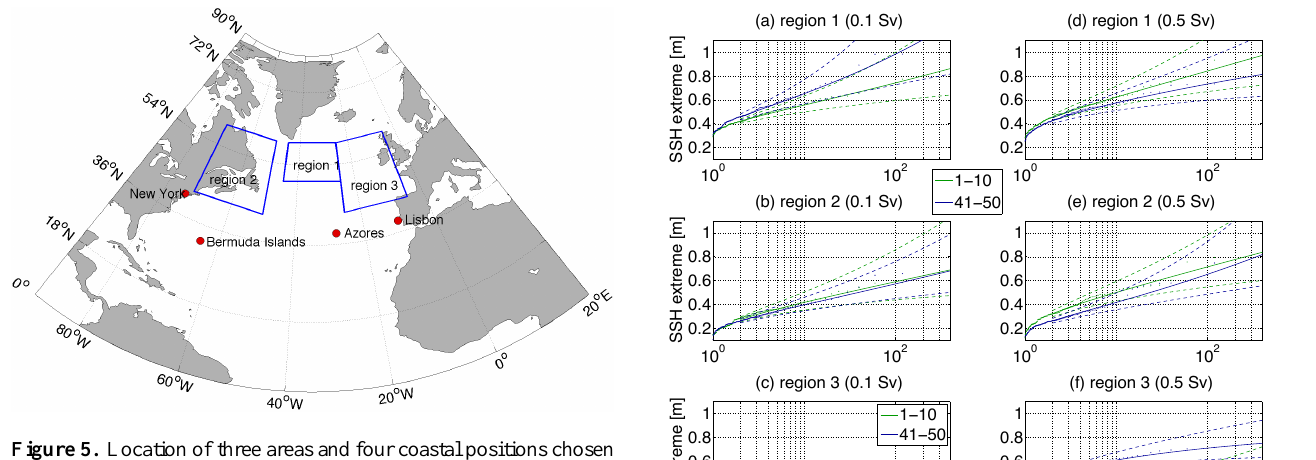
Figure 5. Location of three areas and four coastal positions chosen to investigate extreme regional sea level changes.